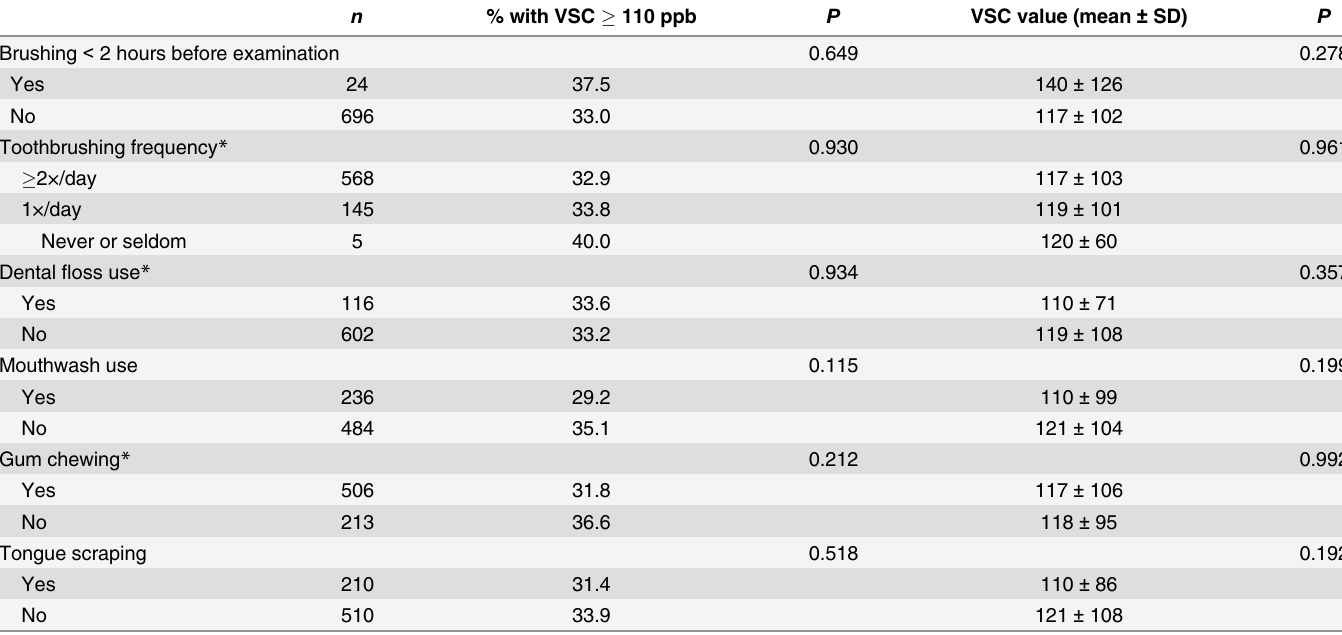
Table 3. Relationships between oral malodor measurements and oral hygiene habits #